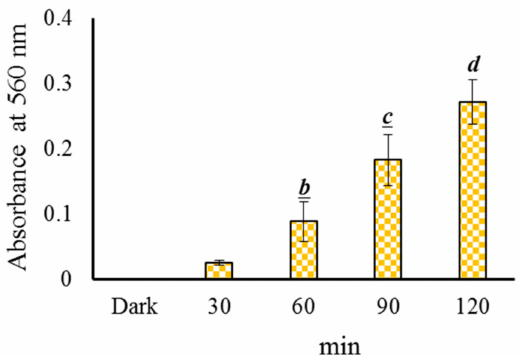
Figure 5. Effects of 50 µ g/mL TC on NBT reduction by blue light illumination at 2.0 mW/cm 2 for 30, 60, 90, and 120 min. Data are represented by mean ± standard deviation, where n = 3. Significant differences ( p < 0.05) between each treatment are indicated by different letters above the